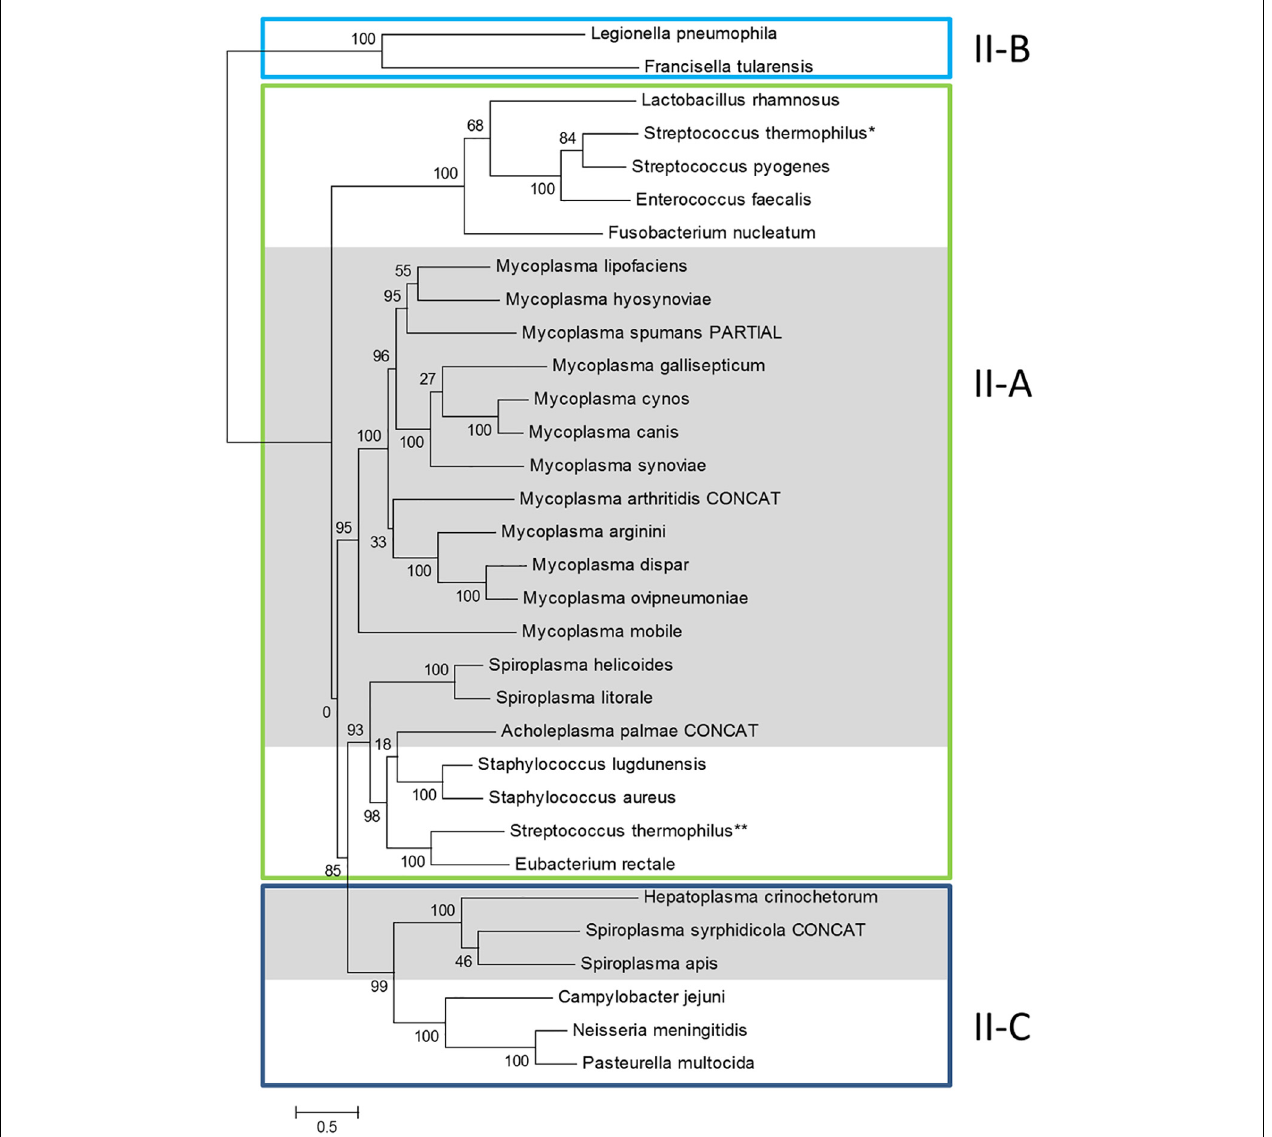
FIGURE 2 | Phylogeny of Cas9 proteins in mollicutes and reference bacteria. Amino-acid sequences of Cas9 proteins were aligned with MSAProbs and phylogenetic tree was reconstructed with PhyML with tools available on phylogeny.fr. For M. arthritidis , A. palmae and S. syrphidicola , Cas9 protein sequences were artificially simulated from fusions of ORFs covering the disrupted gene (indicated with CONCAT). Cas9 from reference bacteria were chosen from Fonfara et al. (2014); proposed subtypes were also defined according to this work; ∗ and ∗∗ refer to the two Cas9 from S. thermophilus also described in this work. Cas9 from mollicutes are highlighted in gray. Cas9 accession numbers are available in Supplementary Table S1